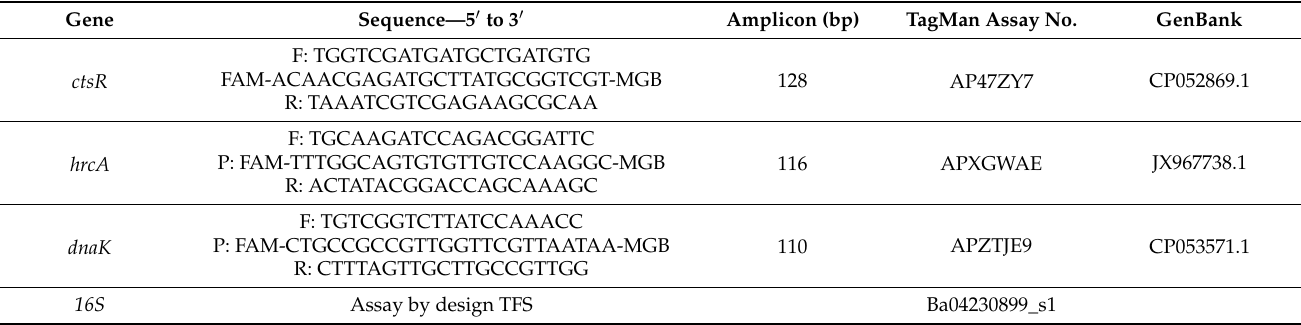
Table 2. Sequence information for primers and probes